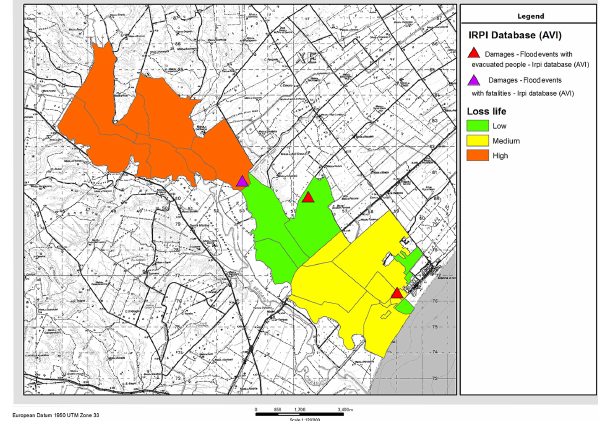
Figure 10. Map of the estimated loss of life divided into categories (low, medium, and high) for the flood event, compared with histor- ical information (AVI project,